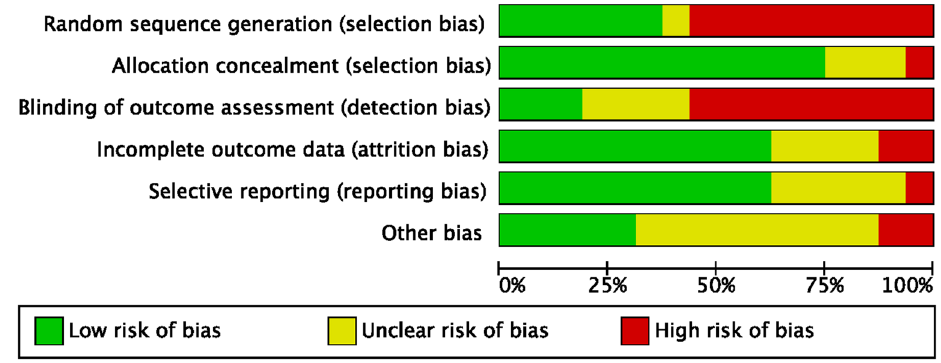
Figure 2. Cochrane risk of bias